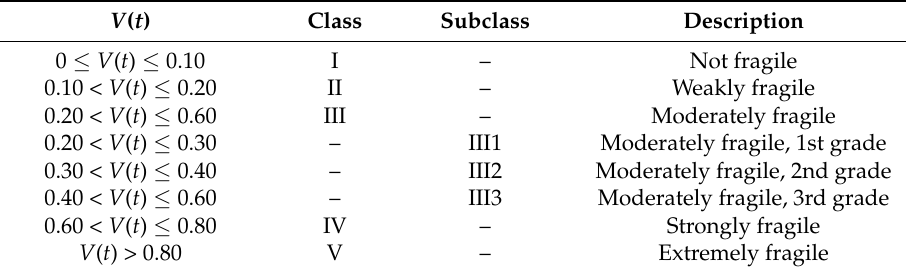
Table 2. Classification of water resource vulnerability ( V ( t